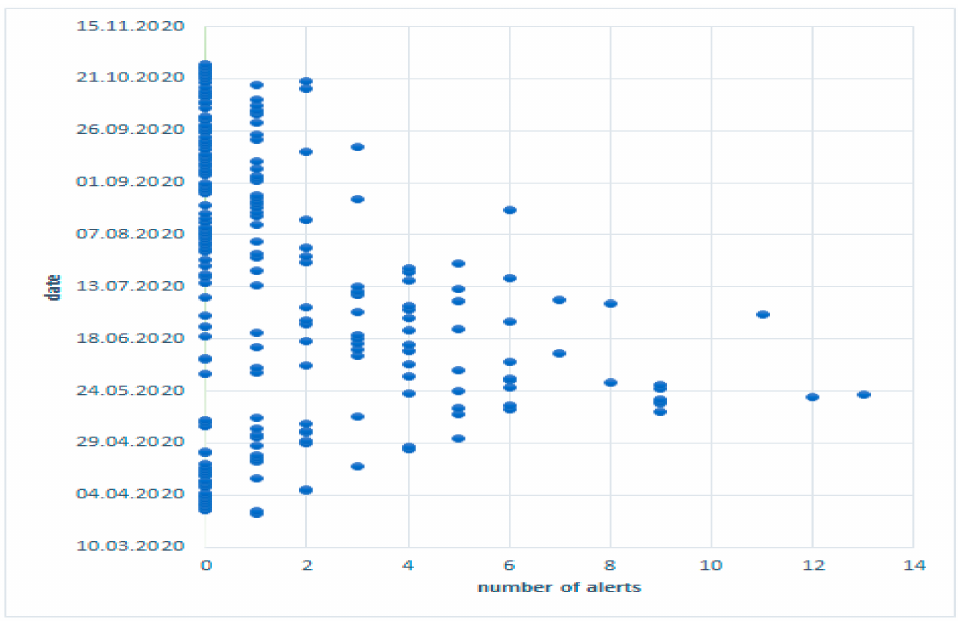
Figure 4. Frequency of posts in the “Wild boars in Olsztyn” group. Source: the